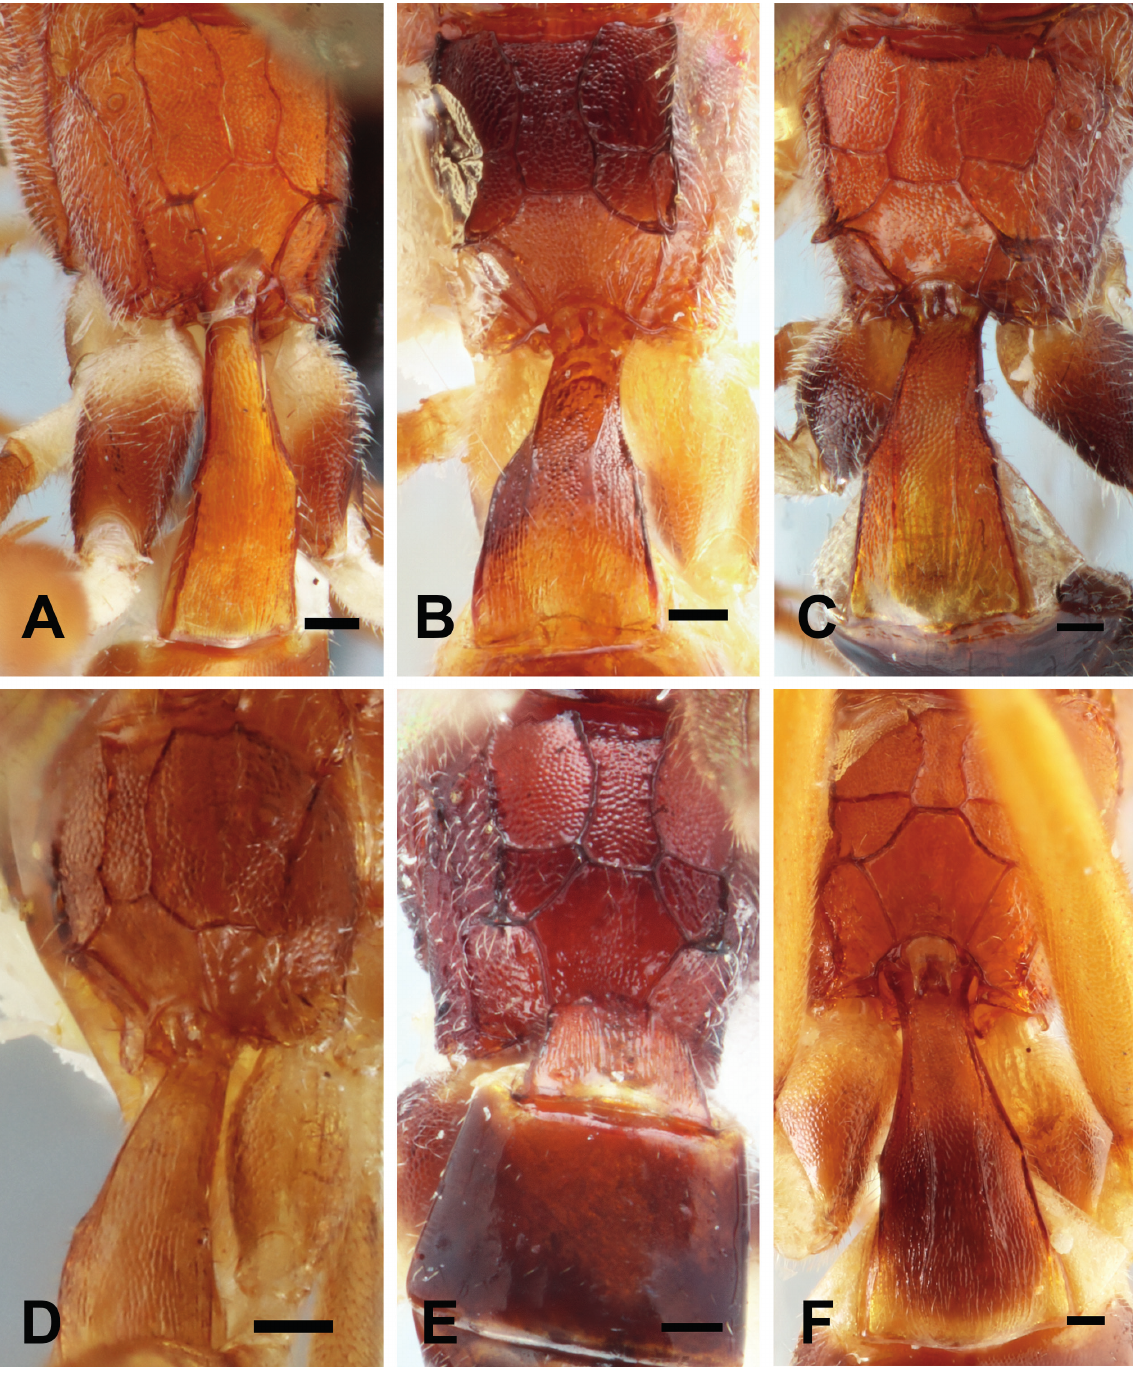
Fig. 1. Propodeum and tergite I of Handaoia spp., ♀♀. A . H. cuscoensis Bordera sp. nov., holotype (AEIC). B . H. fritzi sp. nov., holotype (NHMUK). C . H. mercedensis Bordera sp. nov., holotype (CEUA). D . H. plaumanni sp. nov., holotype (NHMUK). E . H. ruizcancinoi Bordera sp. nov., holotype (CEUA). F . H. urceus sp. nov., holotype (NHMUK). Scale bars: 0.1